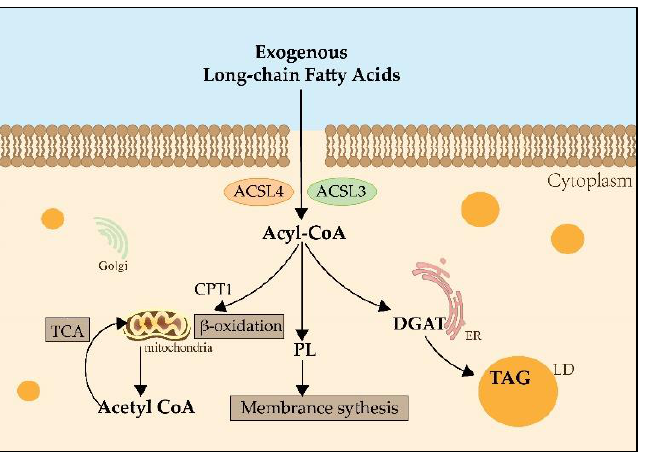
Figure 2. The metabolic pathways of long-chain fatty acids. Both ACSL3 and ACSL4 catalyze exogenous long-chain fatty acids into Acyl-CoA. Acyl-CoA can enter the mitochondria by the transportation of CPT1, then catalyze the formation of Acetyl-CoA and participate in the TCA for providing energy. Acyl-CoA also can produce PLs, which contribute to membrane synthesis. And Acyl-CoA can catalyze DGAT and be involved in the synthesis of TAG in the LDs for lipid storage. CPT1: carnitine palmitoyltransferase 1; TCA: tricarboxylic acid cycle; PLs: phospholipids; DGAT: Diglyceride Acyltransferase; TAG: triglyceride; LD: lipid